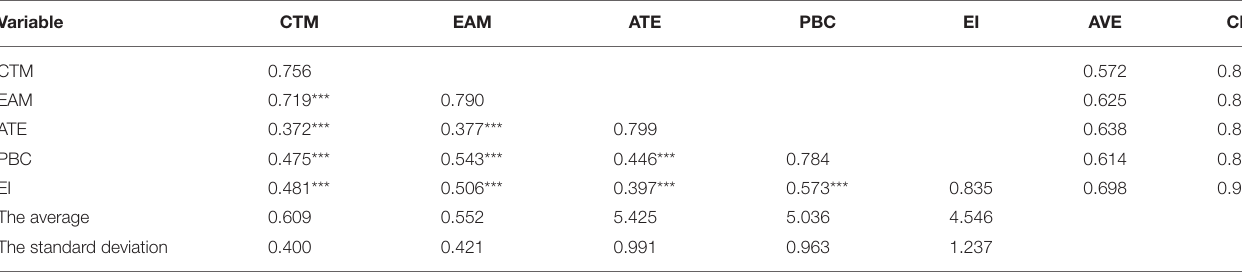
TABLE 4 | Descriptive statistics, correlation coefficient, and AVE and CR values of variables ( N = 514). Variable